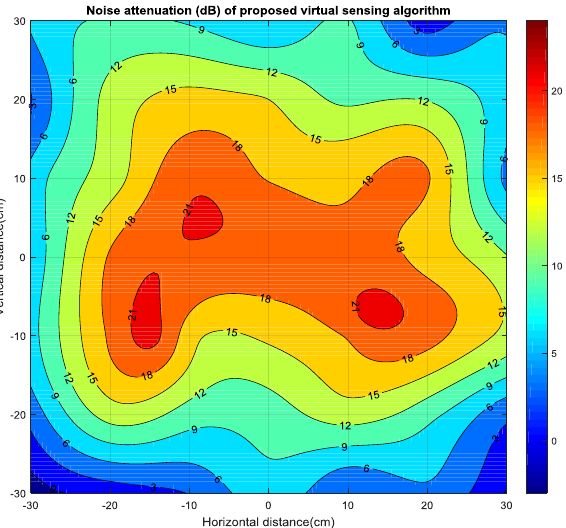
Figure 12. The quiet zone generated by the proposed algorithm with physical microphones located at (15, 15), (−15, 15), (−15, −15) and (15, −15).